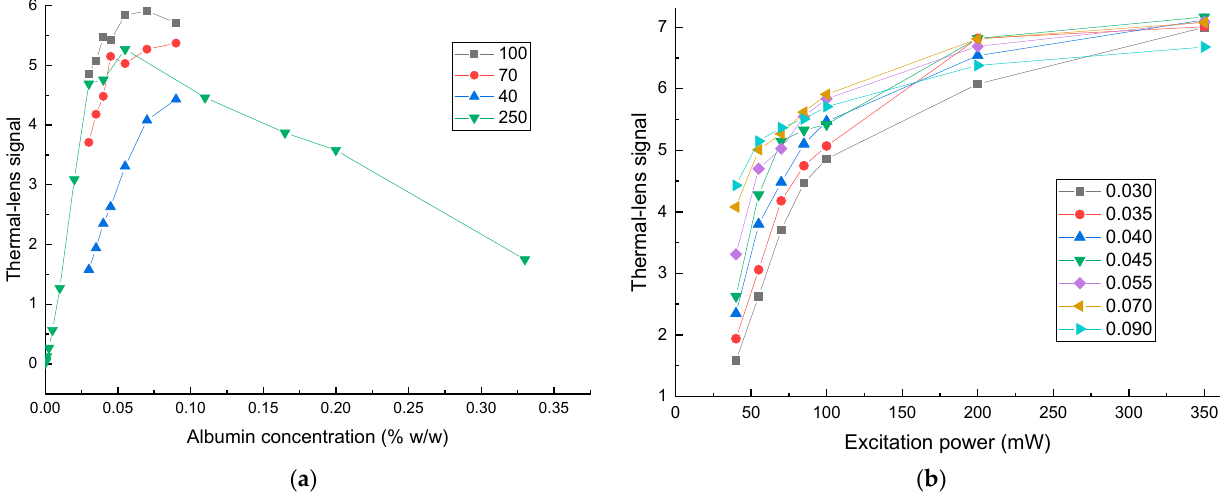
Figure 5. Dependences of the thermal-lens signal (setup, TLS-150; excitation wavelength, 532.0 nm) for myoglobin ( a ) on its concentration at 40, 70, 100, and 250 mW and ( b ) on the laser power for various myoglobin concentrations (in % w / w ).